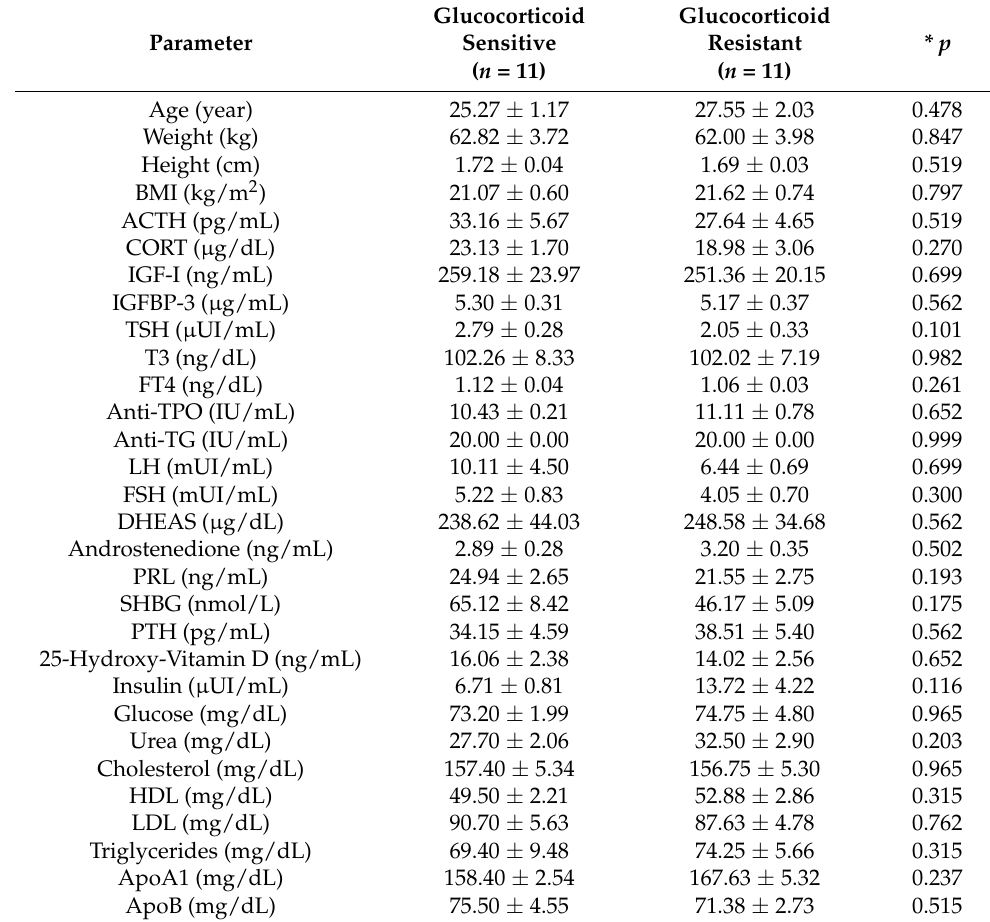
Table 2. Hematological, biochemical, and endocrinological parameters of the S and R healthy subjects determined one month after the very-low dexamethasone suppression